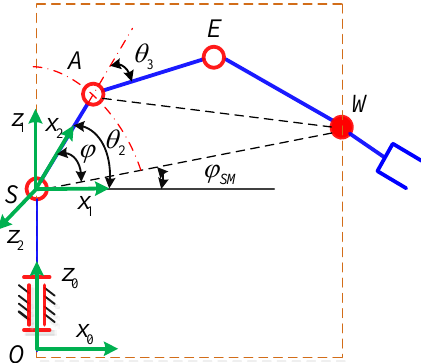
Figure 5. Geometric relationship of joint 2.